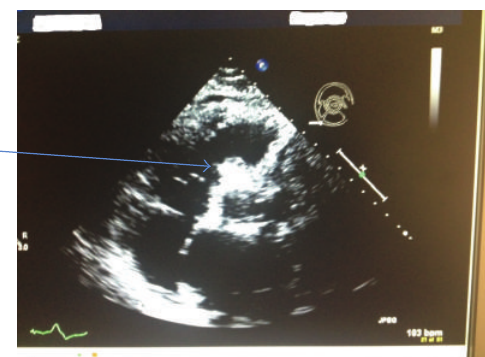
Figure 3: 2D echocardiogram shows the large thrombosed sinus of Valsalva aneurysm (blue arrow). Report: Echocardiogram was done showing no change in ejection fraction from previous studies (55%) with left ventricle concentric hypertrophy in addition to the prosthetic aortic valve, dilated left atrium, a very large and throm- bosed sinus of Valsalva aneurysm, mildly dilated inferior vena cava, a pacemaker lead in the right ventricle, and a catheter/pacemaker lead seen in the RA cavity. It was noted that the right ventricle systolic pressure was elevated at 40–50